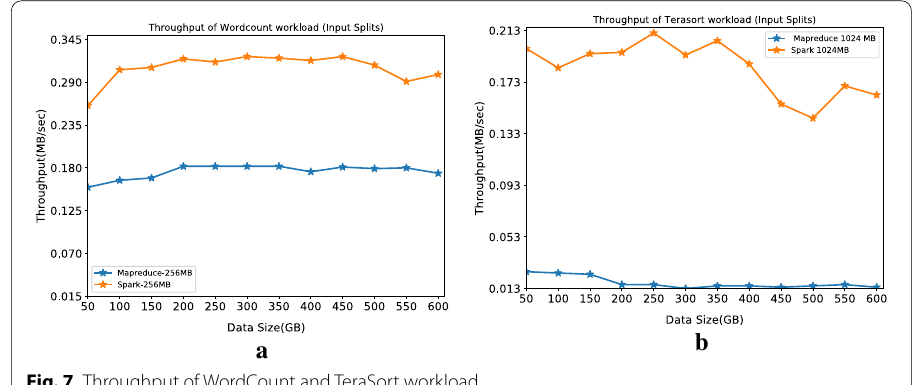
Fig. 7 Throughput of WordCount and TeraSort workload